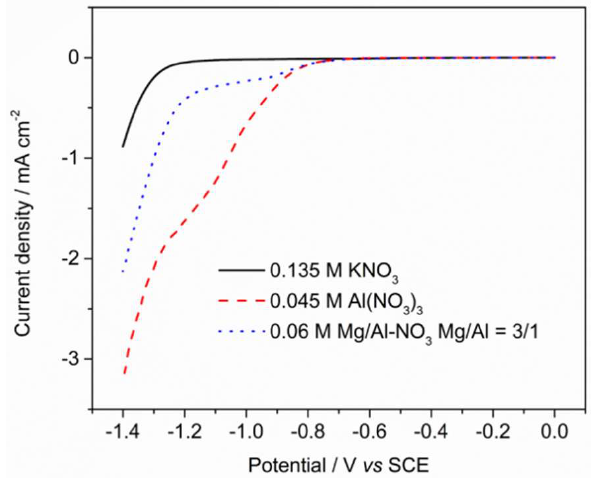
Figure 2. LSV curves recorded at the FeCrAlloy plate dipped in 0.135 M KNO 3 , 0.045 M Al(NO 3 ) 3 , and 0.06 M Mg/Al-NO 3 solutions. Scan rate: 1 mV·s −1 ; Potential range: 0 to −1.4 V. Adapted from [53].